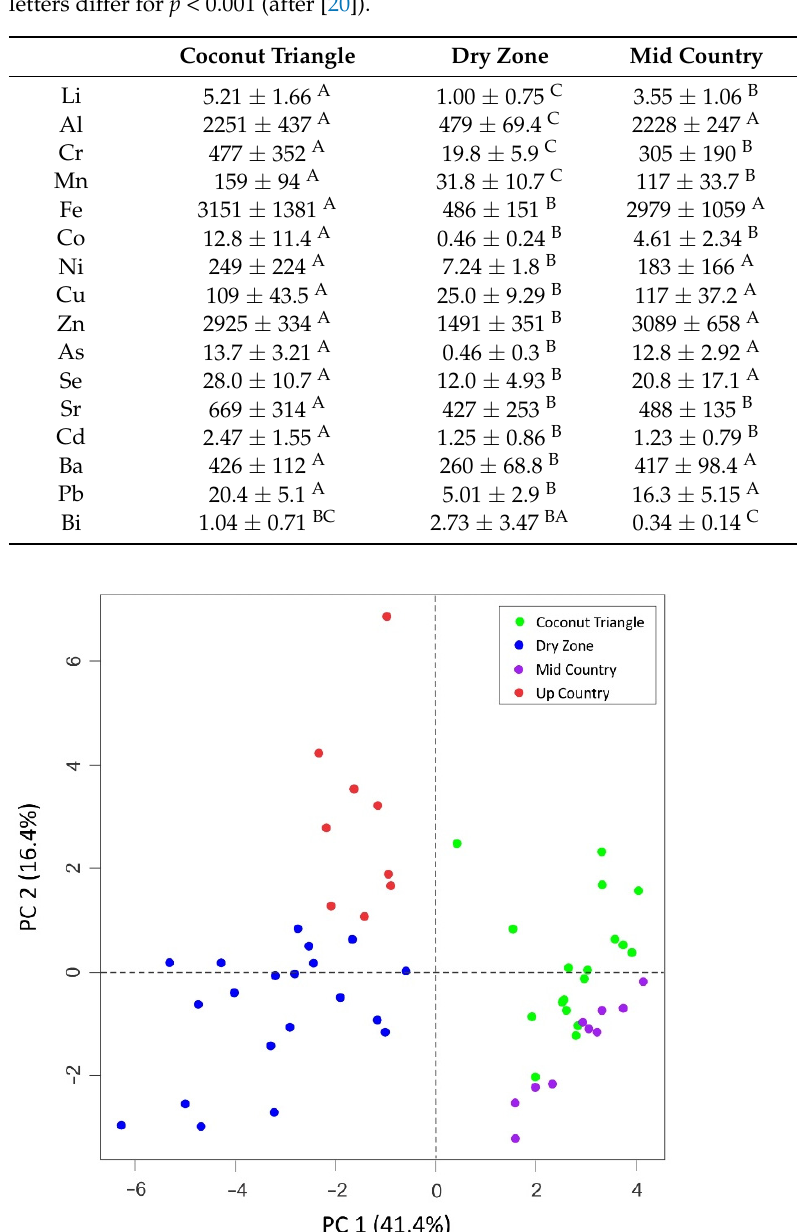
Figure 6. Scatter plot of the PC-1 and PC-2 based on the principal component analysis of stable isotopes and trace element data.